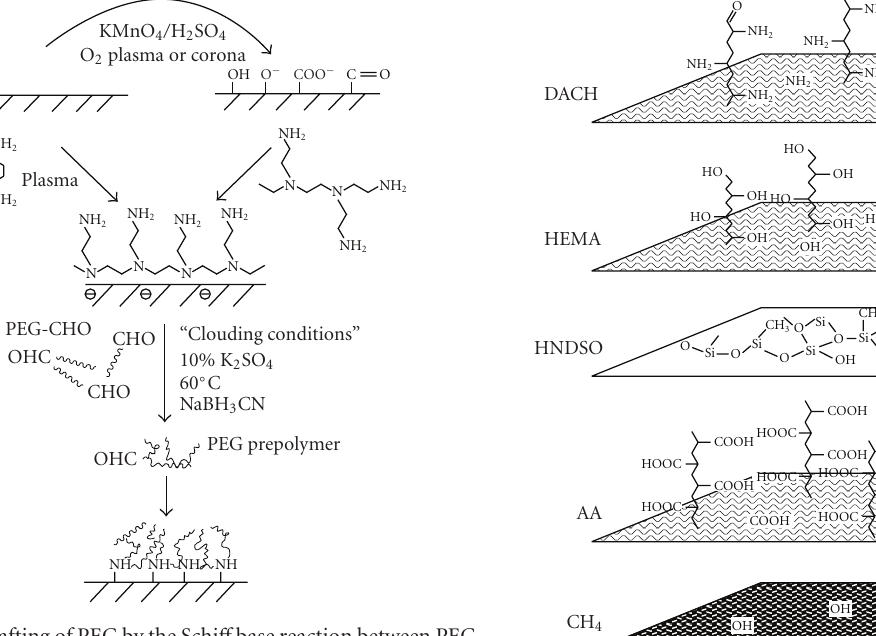
Figure 3: Grafting of PEG by the Schi ff base reaction between PEG- CHO and surface-NH2 on polymer surfaces aminated in various ways, for example by treatment in di-amino-cyclohexane (DACH) plasma or by deposition of polyethyleneimine (PEI) on preoxidated polymer surface [50].